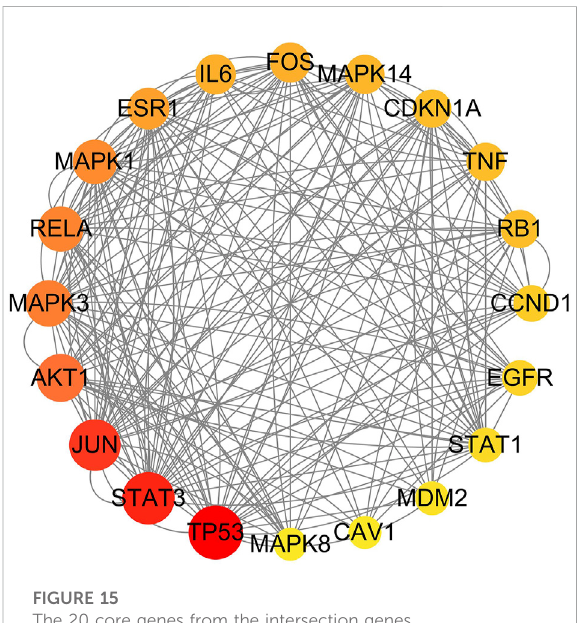
FIGURE 15 The 20 core genes from the intersection